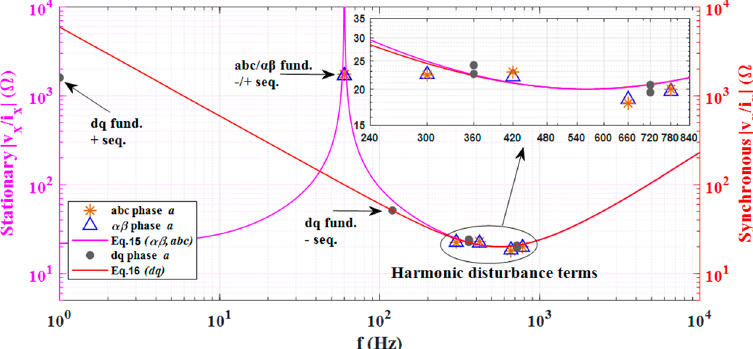
Figure 7. DS analysis experimental results of PI current controller in dq ‐ frame; and fundamental PR current controller in abc ‐ and αβ‐ frame.